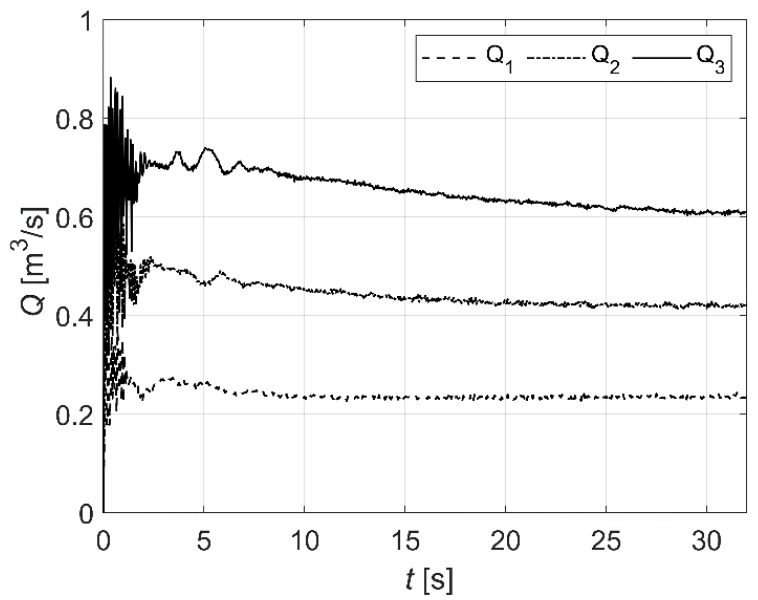
Figure 10. The different flow rates reached steady state condition after 30 s of simulation. The number of particles ranged from a total of 3.6 million in the Q 1 case (of which 2.2 million were fluid particles) to 6.1 million in the Q 3 case (of which 4.7 million were fluid